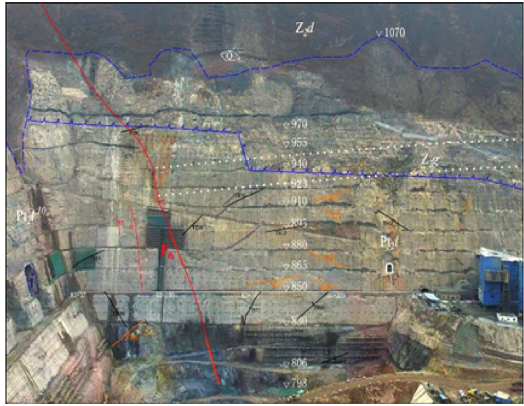
Figure 2: Engineering